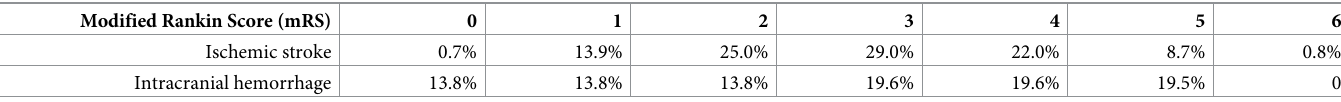
n.b.: All subsets of intracranial hemorrhage are assumed to have equal post-discharge disability.